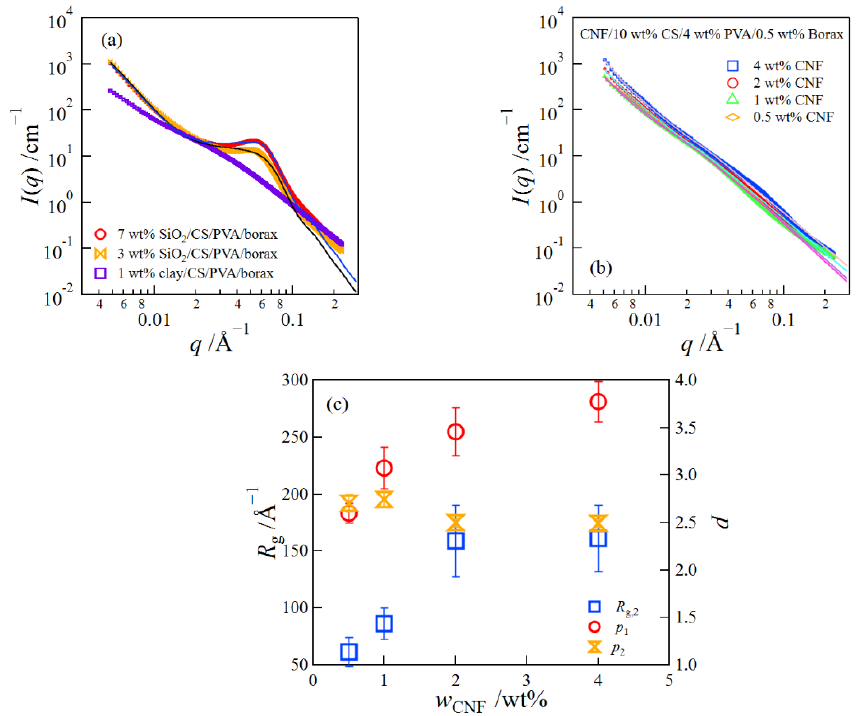
Figure 7. SAXS profiles of clay/CS/PVA/borax and SiO 2 /CS/PVA/borax composite hydrogels ( a ), SAXS profiles of CNF/CS/PVA/borax composite hydrogels at different CNF concentrations ( b ), and the parameters obtained by a fitting analysis ( c ).